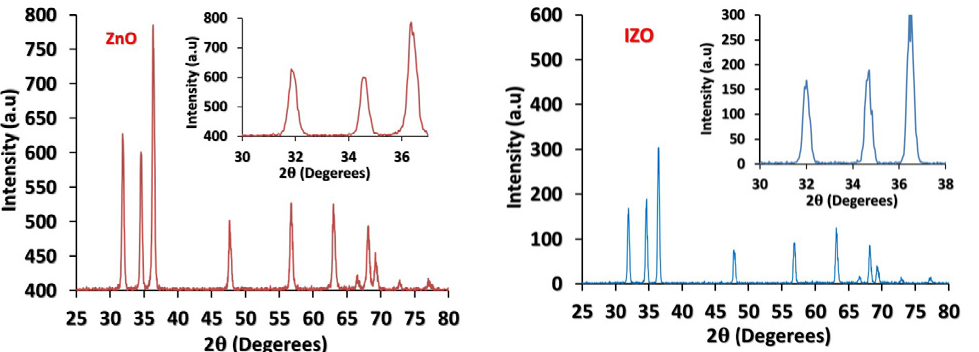
Fig. 1: XRD patterns of ZnO and IZO